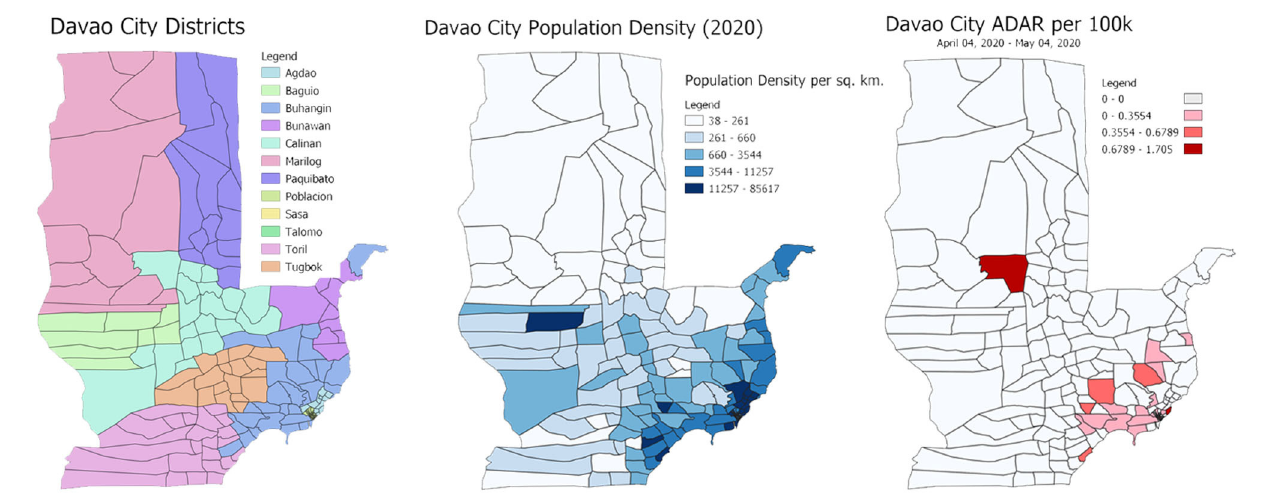
TABLE 7 Summary of Davao City Districts’ information such as scenario category, number of marketplaces per cluster, and number of barangays with confirmed cases. District Total